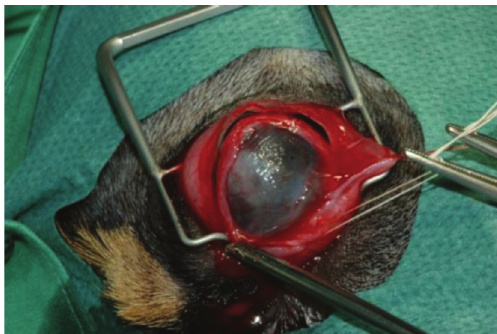
Figure 3: Perilimbal perforating scleral incision as preparation for implantation of intraocular silicone prosthesis.